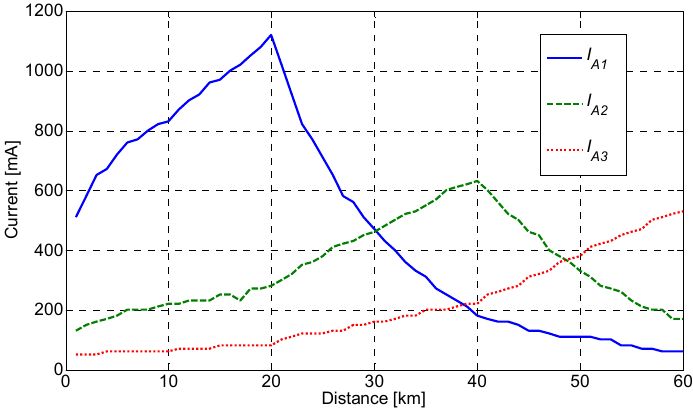
Figure 15. Autotransformers current distribution in the tests with a fault between the catenary and rail.